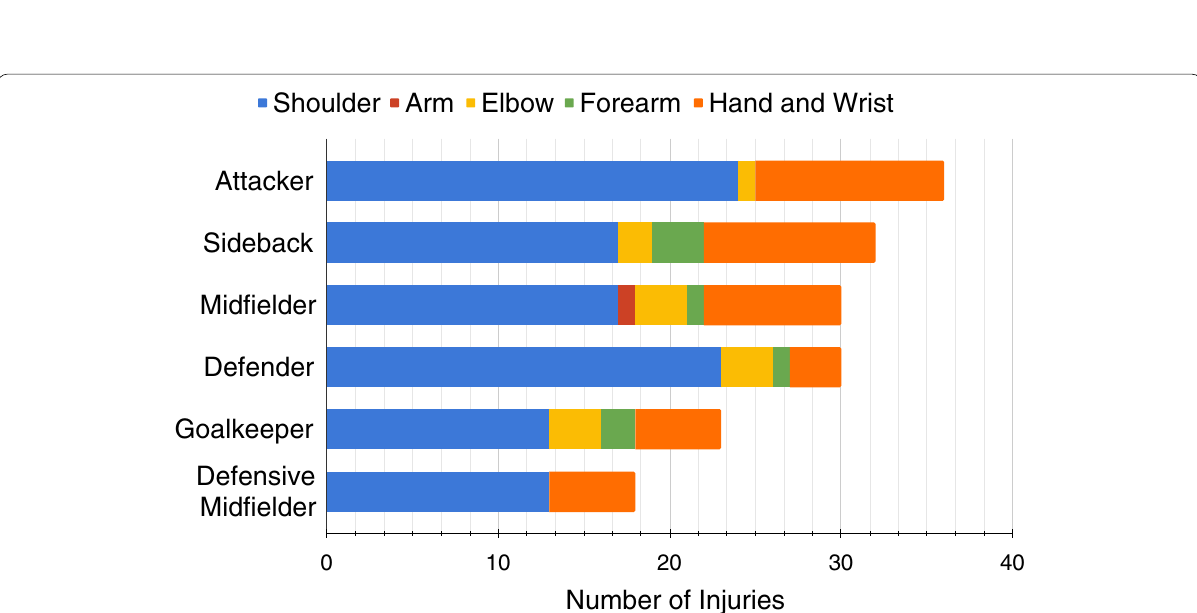
Fig. 1 Upper limb injury incidence distributed by player